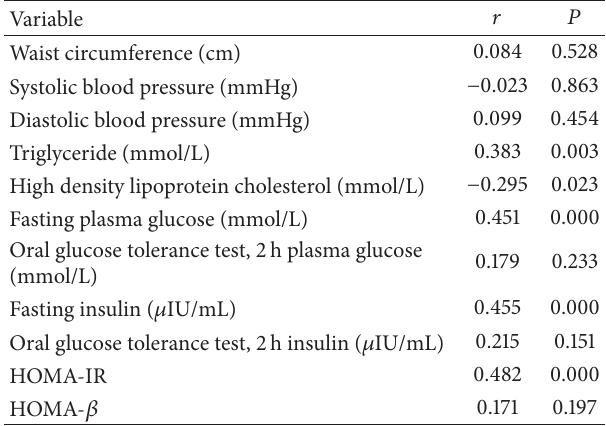
Table 2: Simple correlations between serum ferritin and other variables in the study subjects (after adjustment for age and